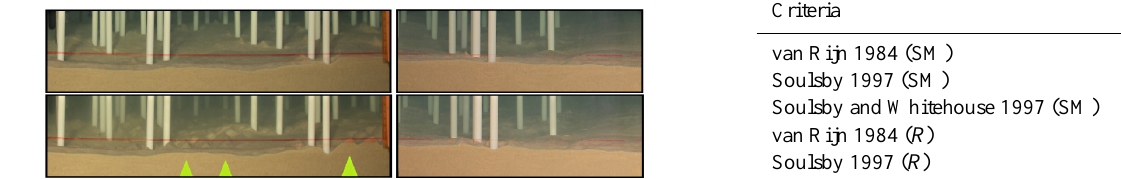
Figure 10. Side view: upstream (left) and downstream (right) edge of the array, before (up) and after (down) 50 waves, H = 0 . 05m, T = 2 . 5s, n = 25m − 2 . Notice the scour and bedforms forming within the array at the upstream section (as pointed by the green arrows) while the downstream section remains unaltered. Notice the factor of 2 increase in the vertical scale.